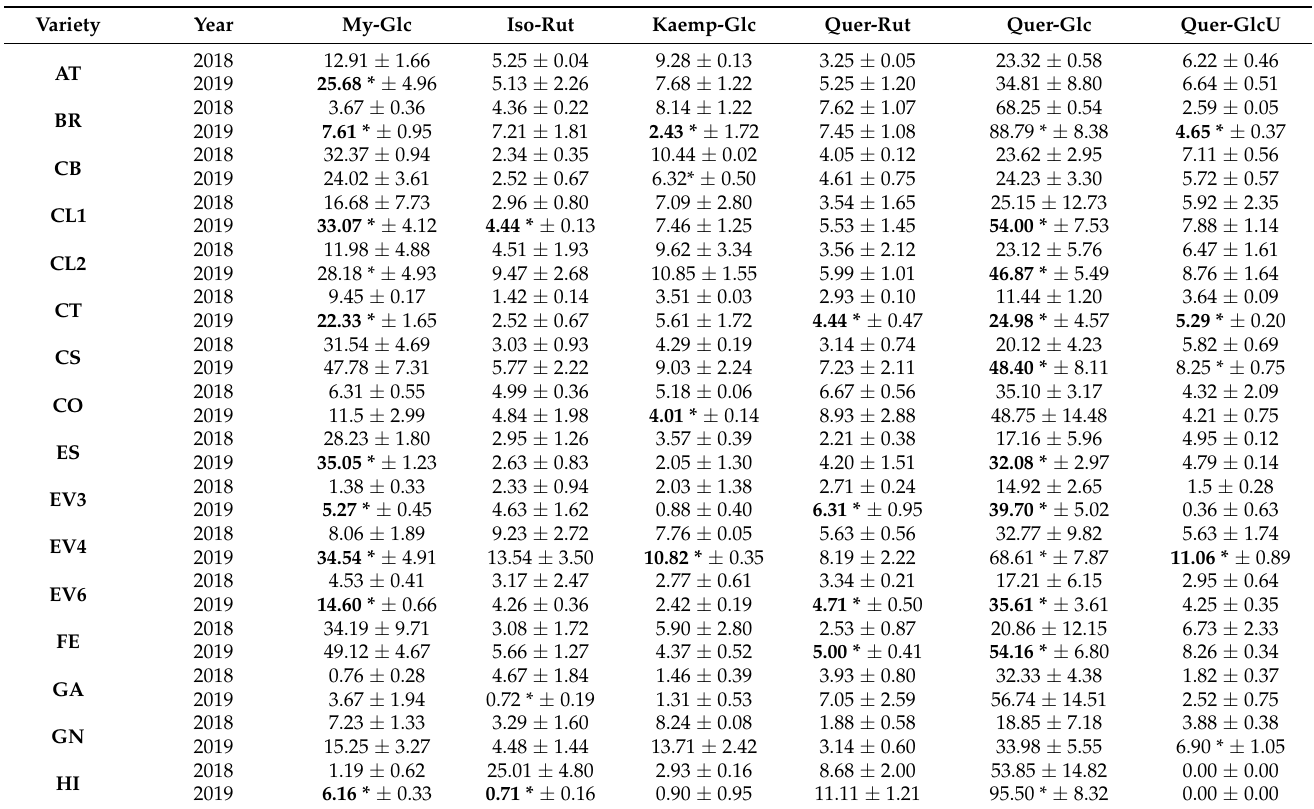
Table 3. Concentration of non-anthocyanin phenolic compounds: flavonols (FLAVO) from